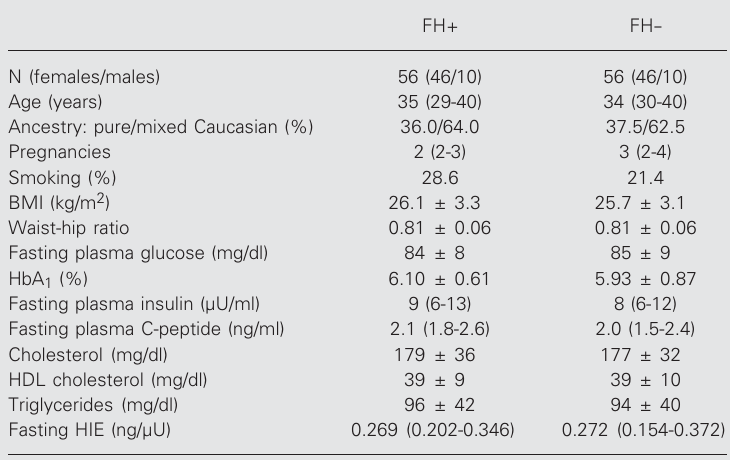
Table 1. Clinical characteristics of individuals with (FH+) and without (FH-) a first- degree relative with type 2 diabetes.